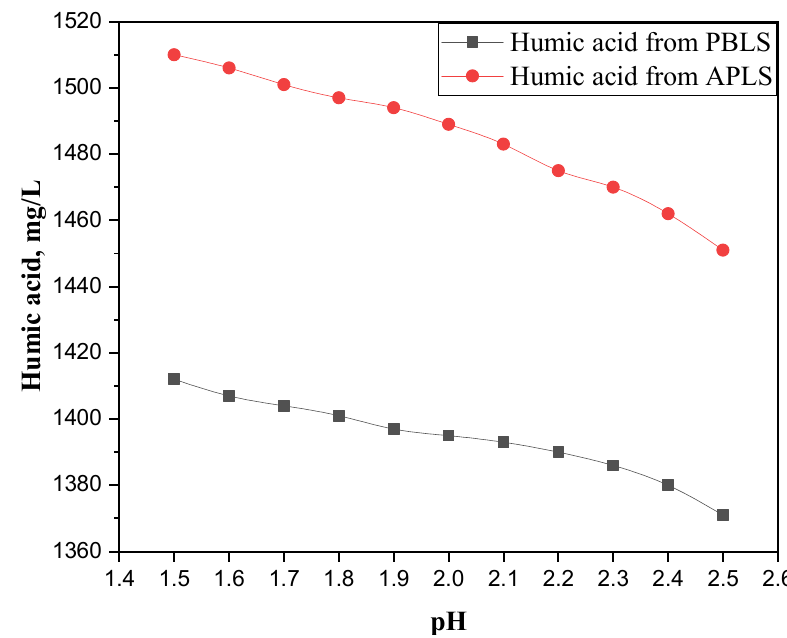
Figure 4. Humic acid isolation at varying pH levels.